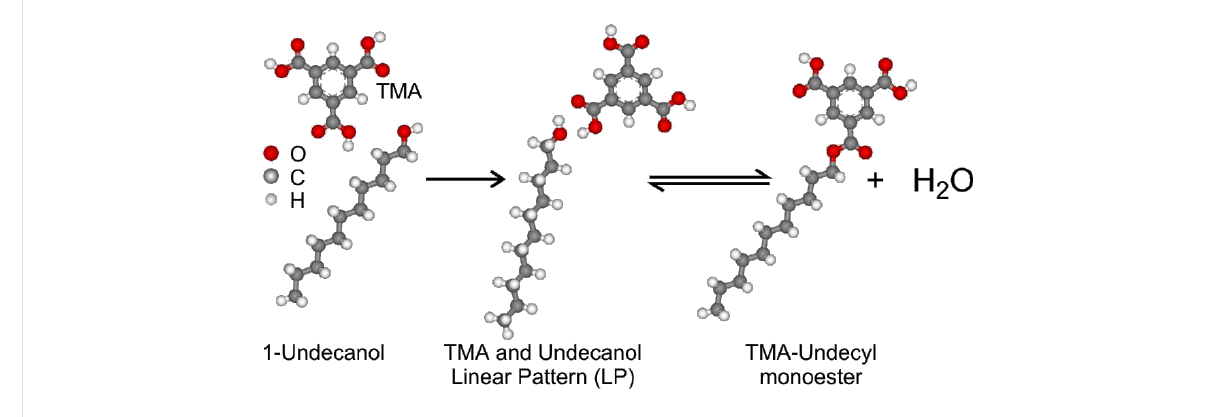
The XC-functional PBE [38], a LCAO dzp basis set, and default values for the self-consistency cut off were used. The starting and end geometry (reactants and products) are first optimized separately, then three points are interpolated and the whole path is relaxed together to find the lowest energy